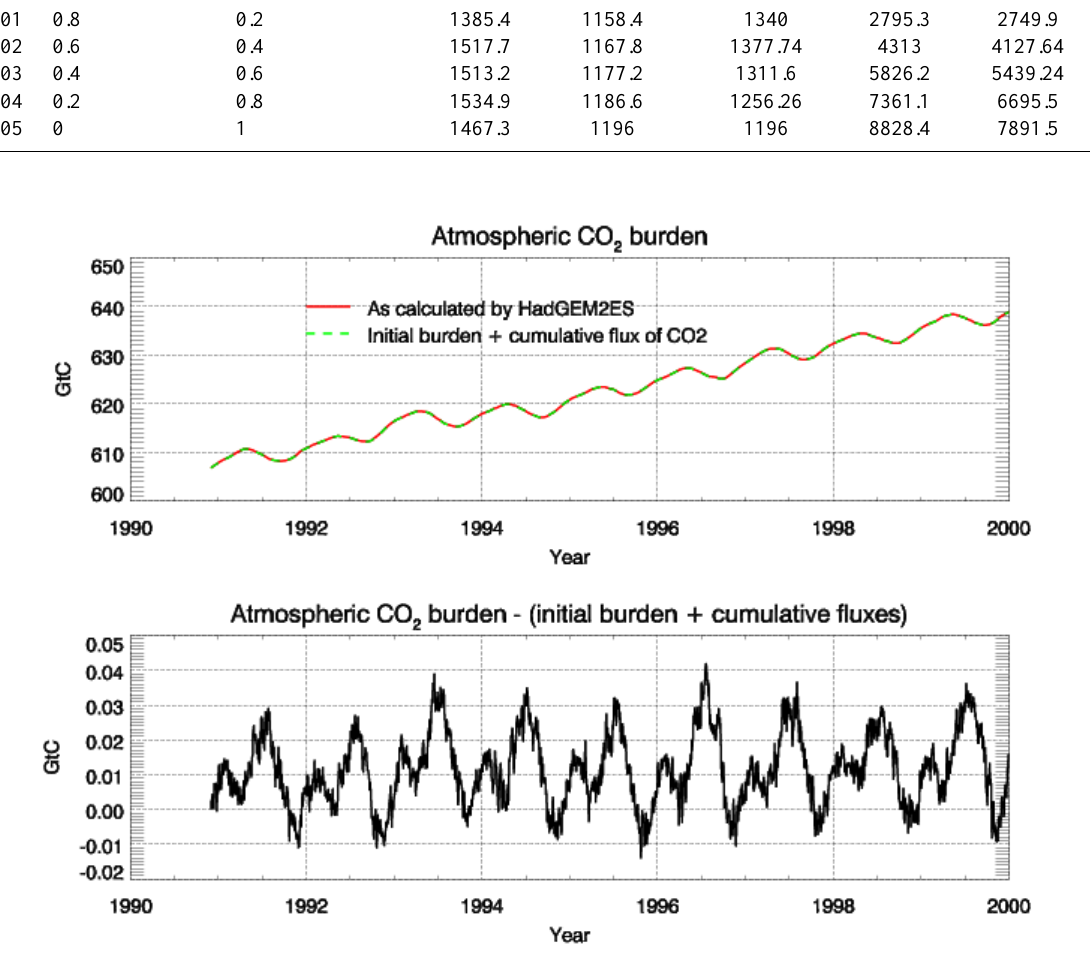
Fig. 5. The evolution of atmospheric CO 2 in HadGEM2-ES. Daily atmospheric CO 2 amount (top panel) simulated by HadGEM2-ES (red line), overlaid with the initial atmospheric burden plus the cumulative sum of CO 2 into the atmosphere (dashed green line). The lower panel shows the difference between the